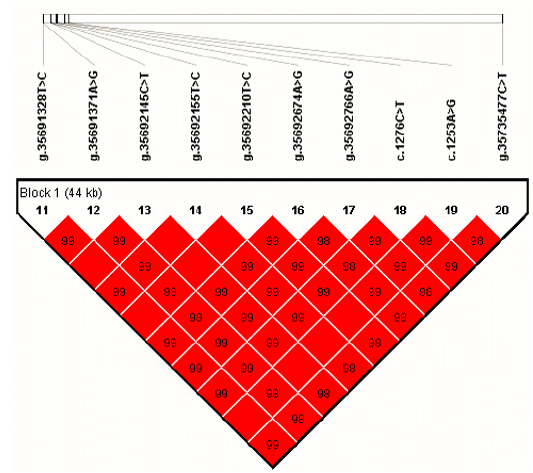
Figure 2. Linkage disequilibrium estimated among the SNPs of NUCB2 (D ′ = 0.98–1.00). The blocks indicate haplotype blocks and the text above the horizontal numbers is the SNP names. The values in boxes are pairwise SNP correlations (D ′ ), while the boxes without numbers indicate complete linkage disequilibrium (LD) (D ′ = 1).